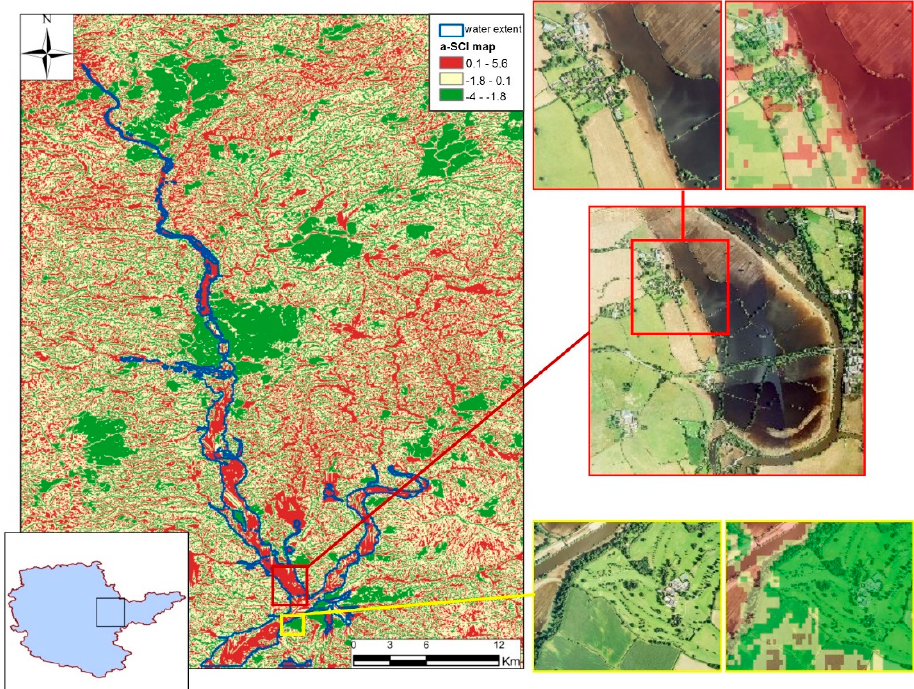
Figure 4. Visual validation of results on a sub-area of the Severn catchment (location map at the bottom-left). Left: a-SCI map with overlaid water extent borders (blue line) relative to the flood event that occurred on July 2007. Right: detailed comparison with aerial photography (res. 1 m, 31 July 2007) showing flooded areas (top, red box) corresponding to high sediment connectivity areas (in red) and non-flooded areas (bottom, yellow box) corresponding to low sediment connectivity areas (in green).